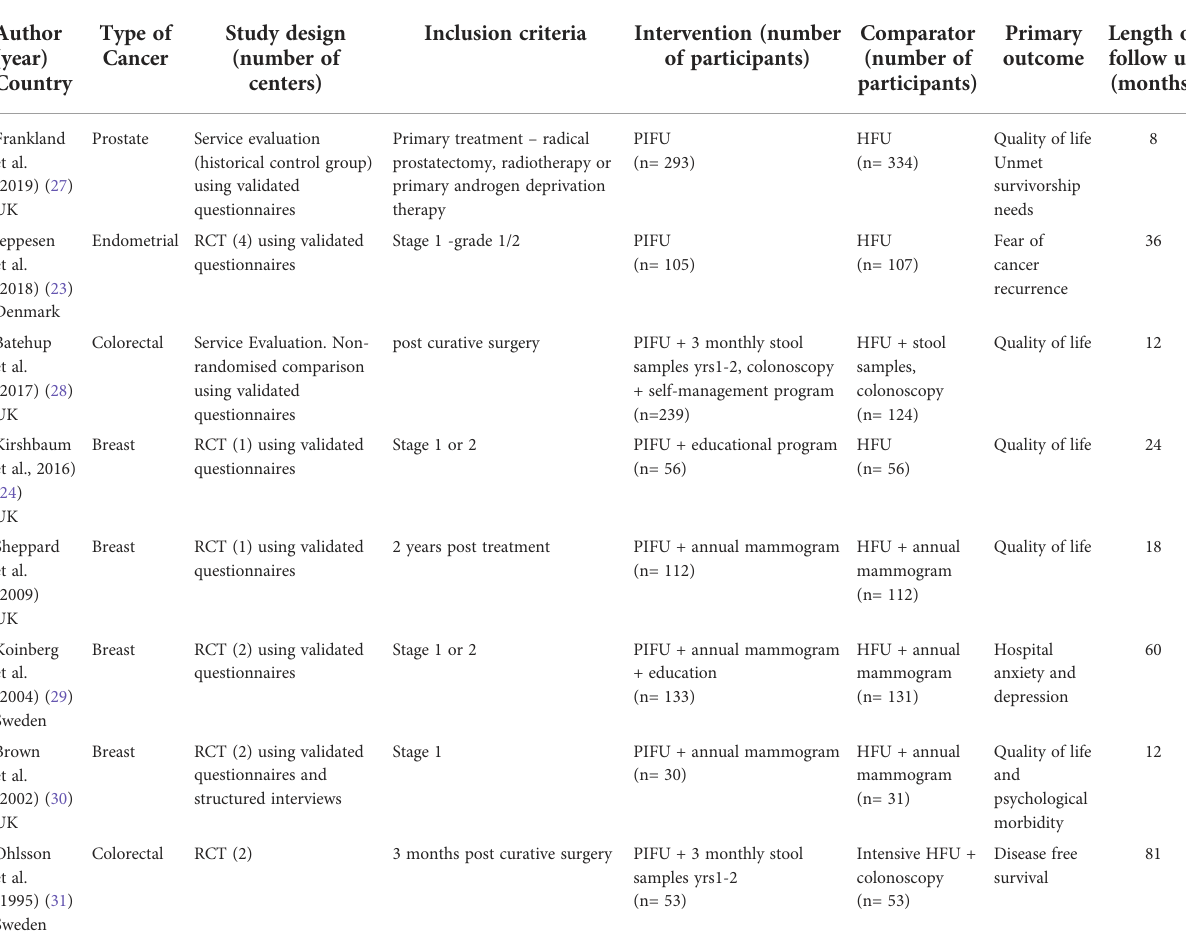
TABLE 1 Summary of included